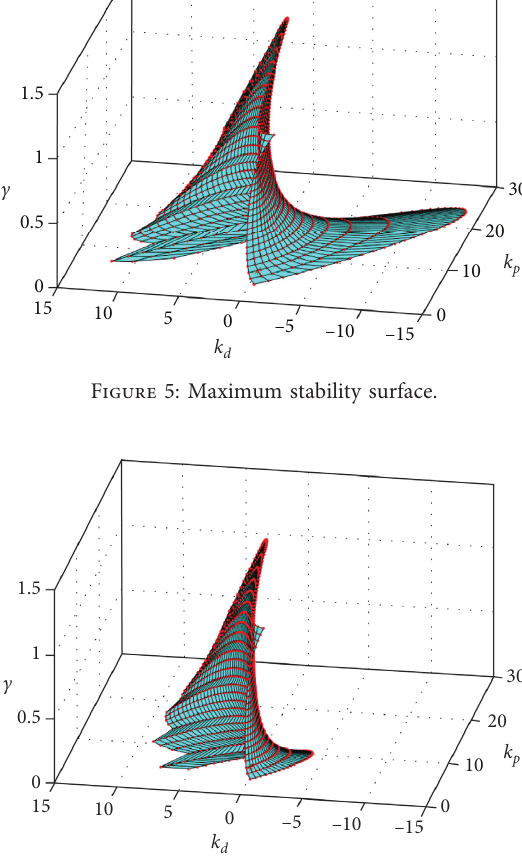
Figure 6: Available stability surface with φ � 45 ∘ .